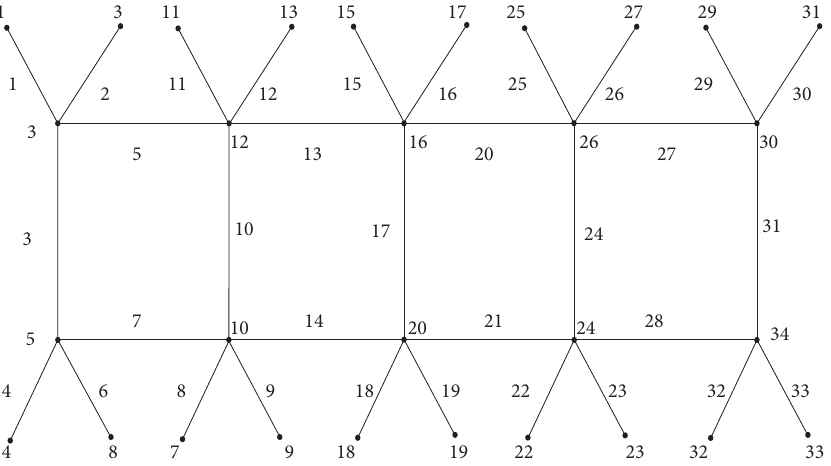
Figure 7: A classical mean labeling of L